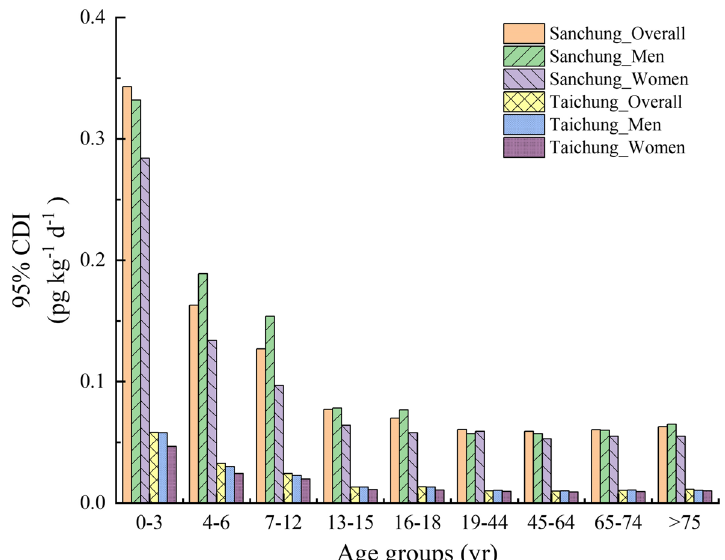
Fig. 3 Chronic daily intake (CDI) of total HBCDs in inhalation pathway